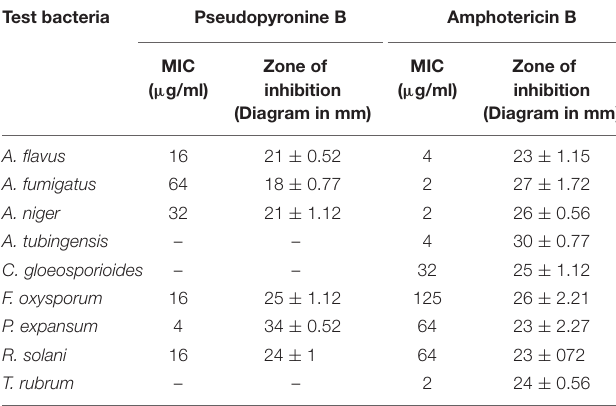
TABLE 2 | Antifungal activity of Pseudopyronine B. Test bacteria